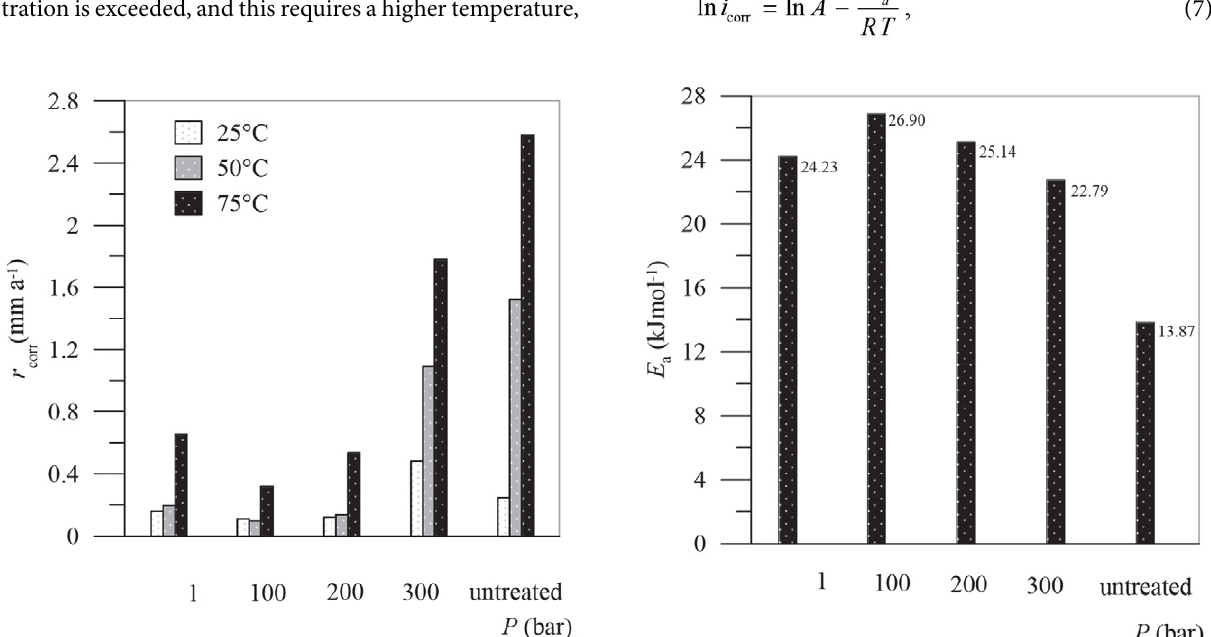
Figure 11. Activation energy values for AISI 347 in dependence of pressure